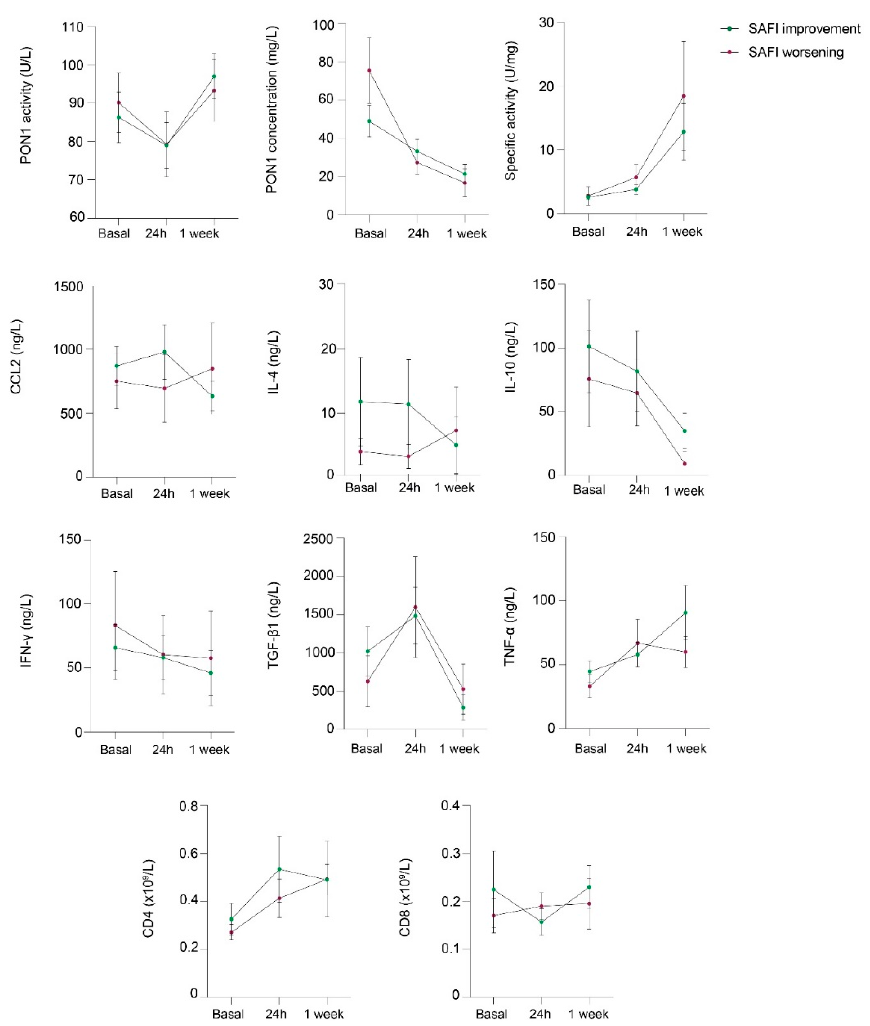
Figure 5. Selected variables in patients with COVID-19 pneumonia according to whether they showed a SaFI improvement or a worsening after 1 week of low-dose radiation therapy. Abbreviations: CCL2, chemokine (C-C motif) ligand 2; CD, cluster of differentiation; IFN- γ , interferon γ ; IL, interleukin; PON1, paraoxonase-1; TGF- β 1, transforming growth factor beta 1; TNF- α , tumor necrosis factor α